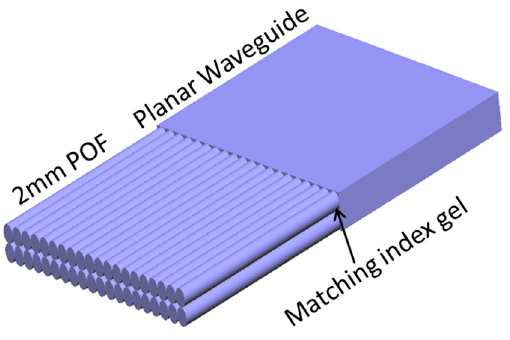
Figure 7. A ribbon arrangement of optical fiber is coupled with planar waveguide.